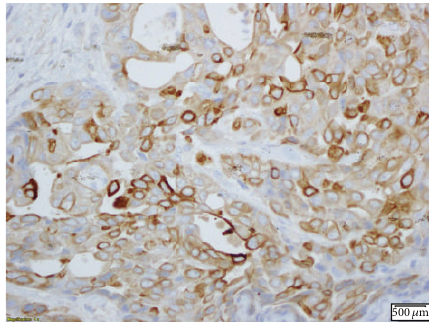
Figure 4: IHC stain positive for CK 5/6.